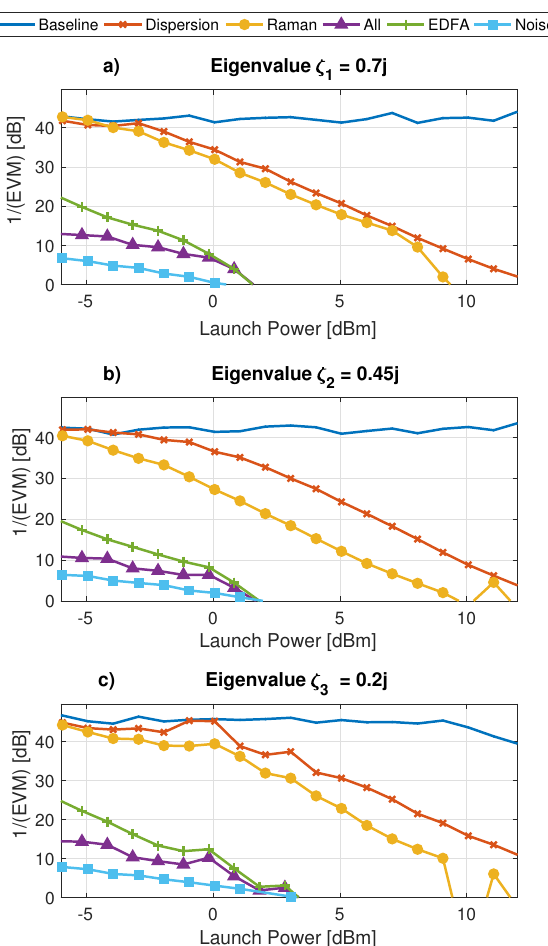
Figure 16. The reciprocal of the EVM as a function of the launch power when all the effects are included and the symbol period is equal to T S2 . ( a ) Results of the signal that is decoded from the first eigenvalue ζ 1 = 0.7 j . ( b ) Results of the signal that is decoded from the second eigenvalue ζ 2 = 0.45 j . ( c ) Results of the signal that is decoded from the third eigenvalue ζ 3 = 0.2 j